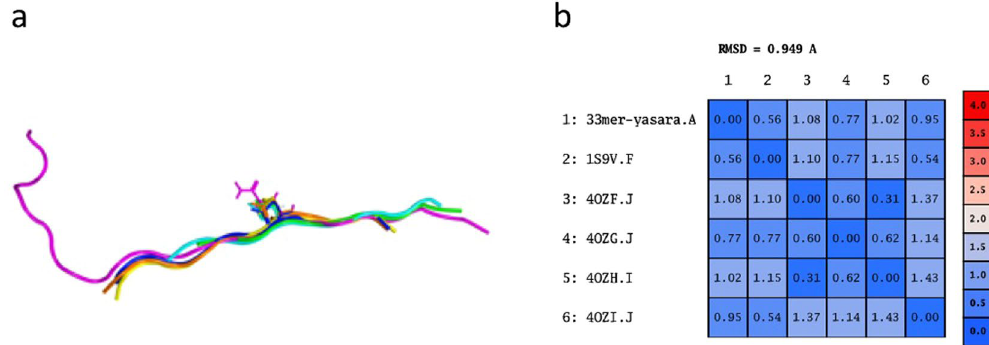
Figure 1. Homology modelling of α 2-gliadin . ( a ) Superposition of the 3D structures of templates (1S9V in green, 4OZF in blue, 4OZG in yellow, 4OZH in orange, and 4OZI in cyan) and the homology model (magenta). ( b ) RMSD matrix values of the positions of the C α atoms for each pair of peptides.